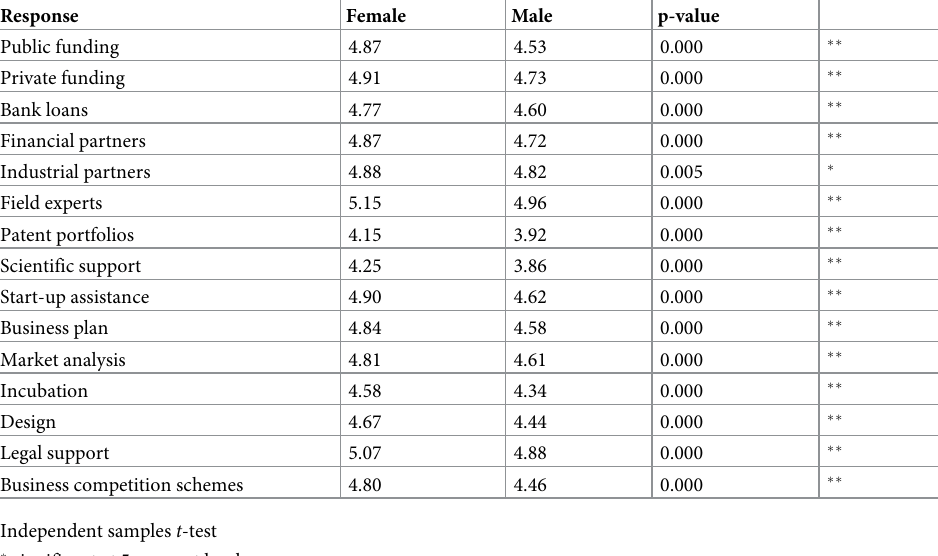
Table 1. Students’ opinion about the relevance of drivers to entrepreneurship. Response